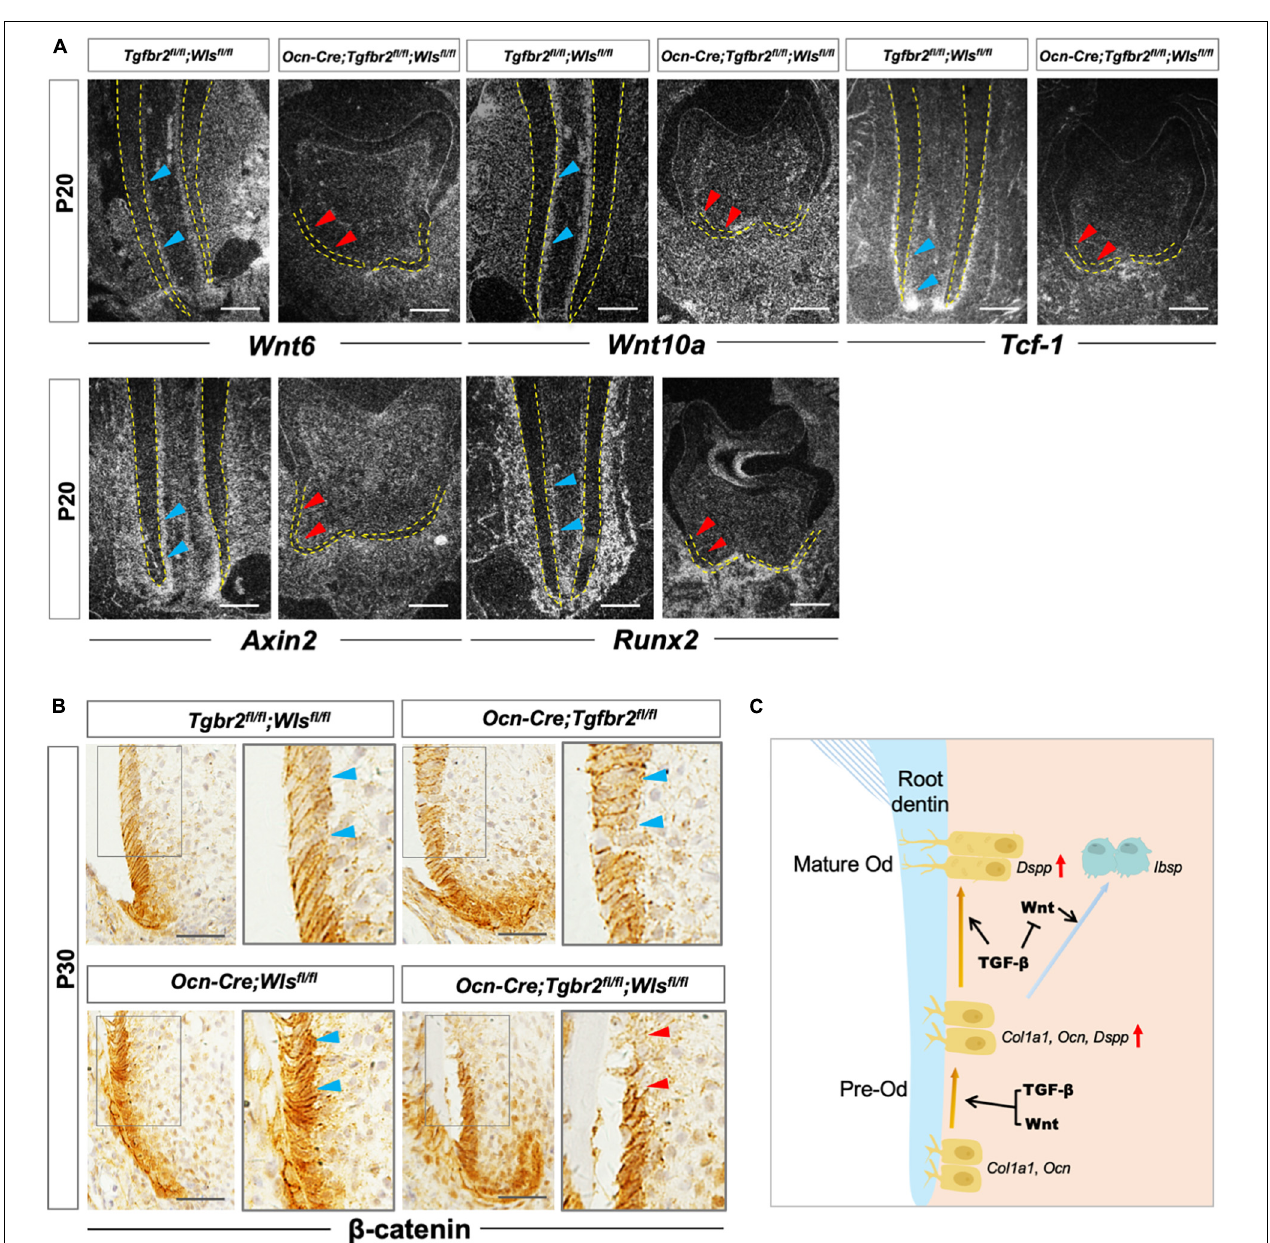
FIGURE 5 | Compromised Wnt/ β -catenin signaling in Ocn-Cre; Tgfbr2 fl / fl ; Wls fl / fl mice. (A) Downregulated expression of Wnt related genes and Runx2 in Ocn-Cre ; Tgfbr2 fl / fl ; Wls fl / fl mice indicated by red arrowheads at P20. (B) Reduced expression of β -catenin in odontoblasts of Ocn-Cre ; Tgfbr2 fl / fl ; Wls fl / fl mice indicated by red arrowheads at P30. (C) The scheme representation of possible mechanisms of TGF- β and Wnt signaling pathways in pre-odontoblast differentiation during tooth root development. Blue arrowheads indicate expression of Wnt6 , Wnt10a , Tcf-1 , Axin2 , and Runx2 in Tgfbr2 fl / fl ; Wls fl / fl mice (A) , and expression of β -catenin in Tgfbr2 fl / fl ; Wls fl / fl mice, Ocn-Cre ; Tgfbr2 fl / fl mice, and Ocn-Cre ; Wls fl / fl mice (B) . Red arrowheads indicate downregulated expression of Wnt6 , Wnt10a , Tcf-1 , Axin2 , and Runx2 (A) , and reduced β -catenin expression in Ocn-Cre ; Tgfbr2 fl / fl ; Wls fl / fl mice (B) . N = 4 mice/per genotype in (A,B) . The right panels show the high-magnification image of the area boxed in gray on the left. Od, odontoblast. Scale bars: 50 µ m (A) and 25 µ m (B) .